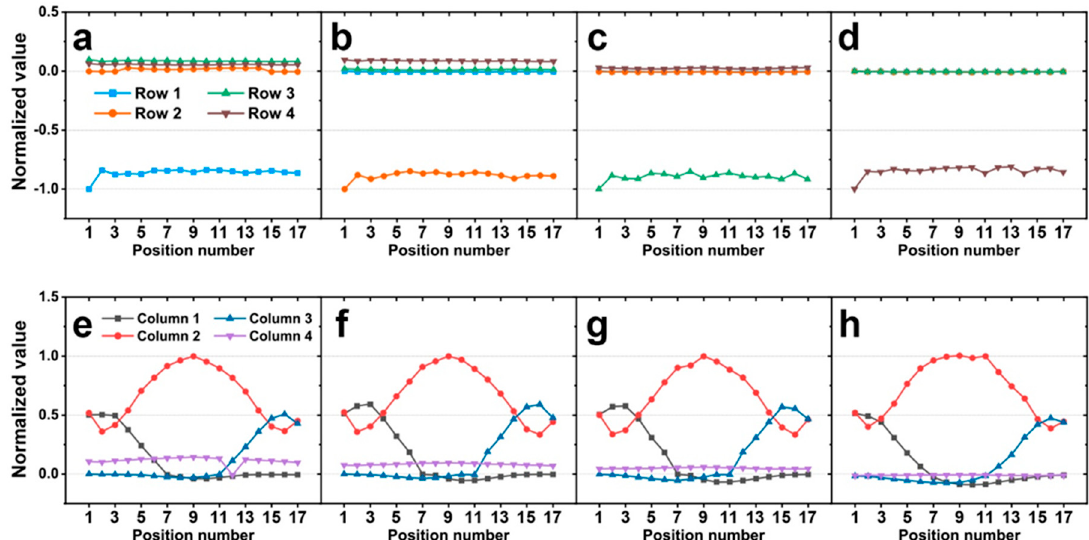
Figure 5. Simulation results of the normalized value from the output voltages of a sensor ( a,e ) when 1 N of force was applied to row 1, ( b,f ) when 1 N of force was applied to row 2, ( c,g ) when 1 N of force was applied to row 3, and ( d,h ) when 1 N of force was applied to row 4. The graphs above show the response of the row sensors, and the graphs below show the response of the column sensors.